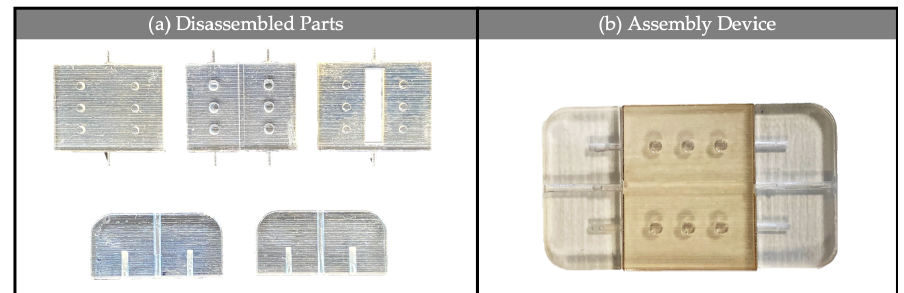
Figure 8. 3D printed parts in VeroClear RGD810 ( a ) and assembled device ( b